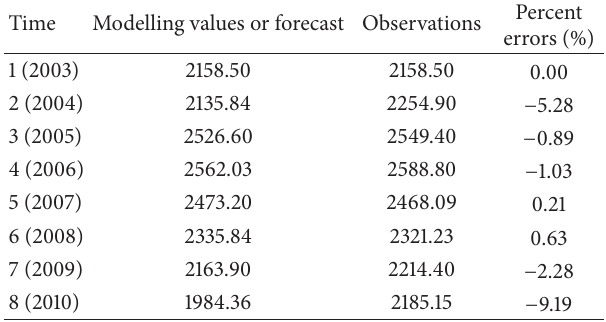
Table 7: The modelling values and forecasts of China’s industrial emissions by NGMC SO 2